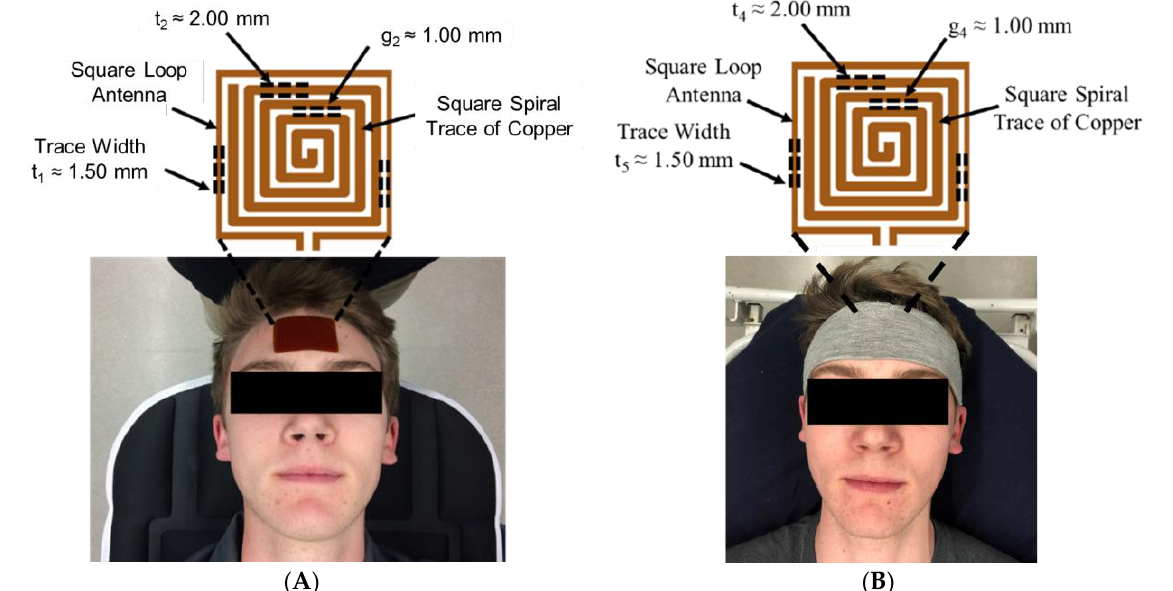
Figure 1. EM skin patch sensor placement ( A ) adhered to forehead (prior work) and ( B ) embedded into a wearable headband (this study). Data was collected from human participants during induce bio-fluid shift (following an IRB approved protocol).